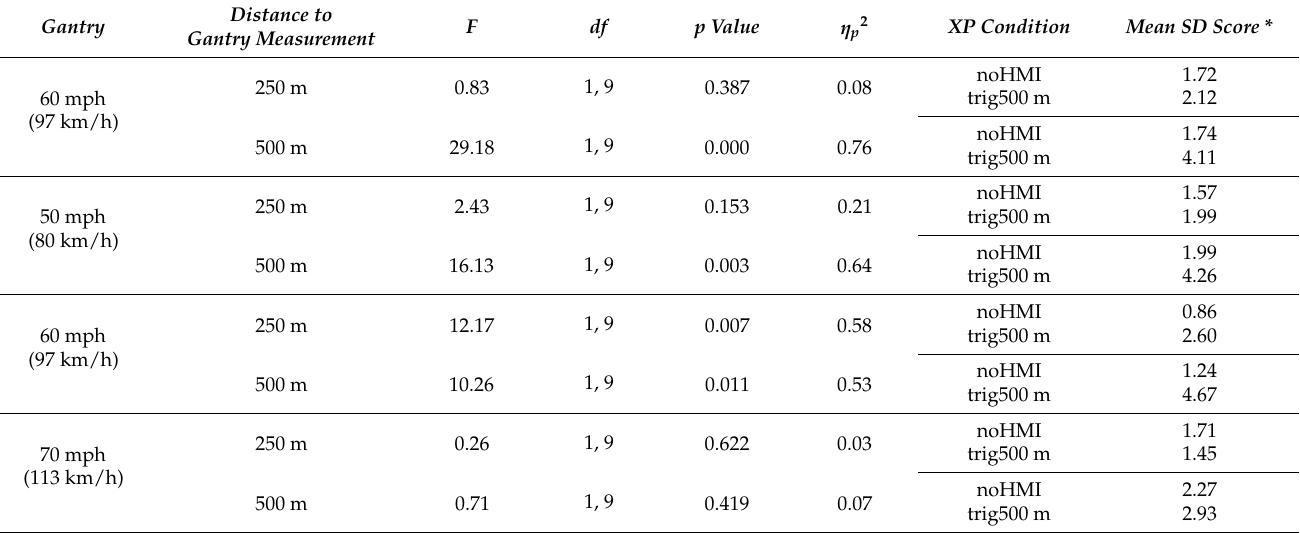
Table 14. Repeated measures ANOVA conducted to compare speed homogeneity between the noHMI and the trig500 m condition for the same sequence of gantries. Scores reported in